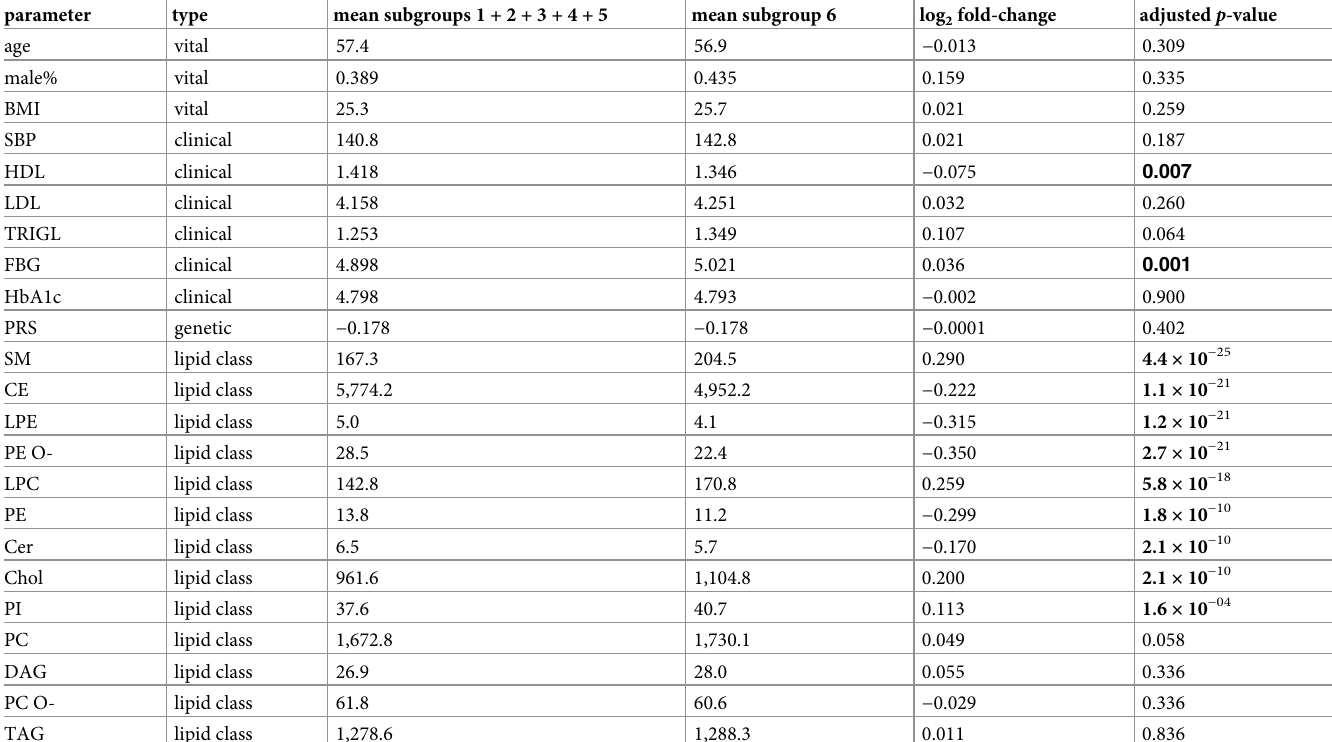
Table 3. Comparison of vital, clinical, genetic, and lipidomic variables between participants from subgroup 6 and the other participants. t Tests were used except for the fraction of males for which a chi-squared test on the absolute counts was applied. p -Values were adjusted for multiple testing; bold font indicates adjusted p -values smaller than